Question: Identify the chart type used in this figure.
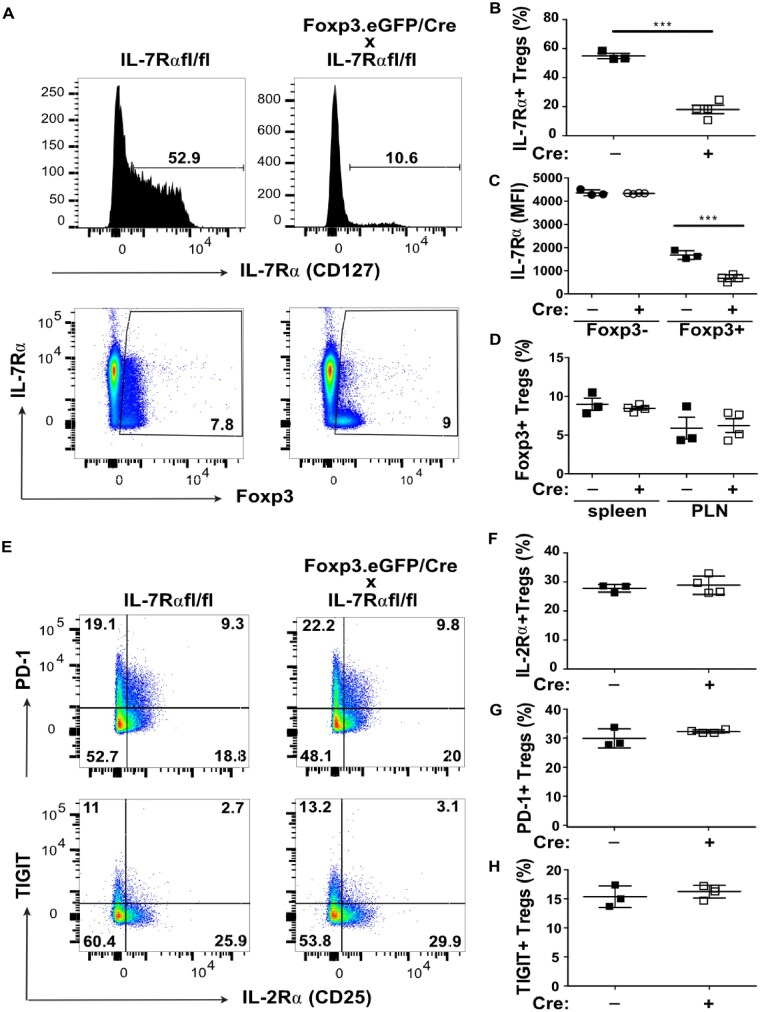
Answer: histogram